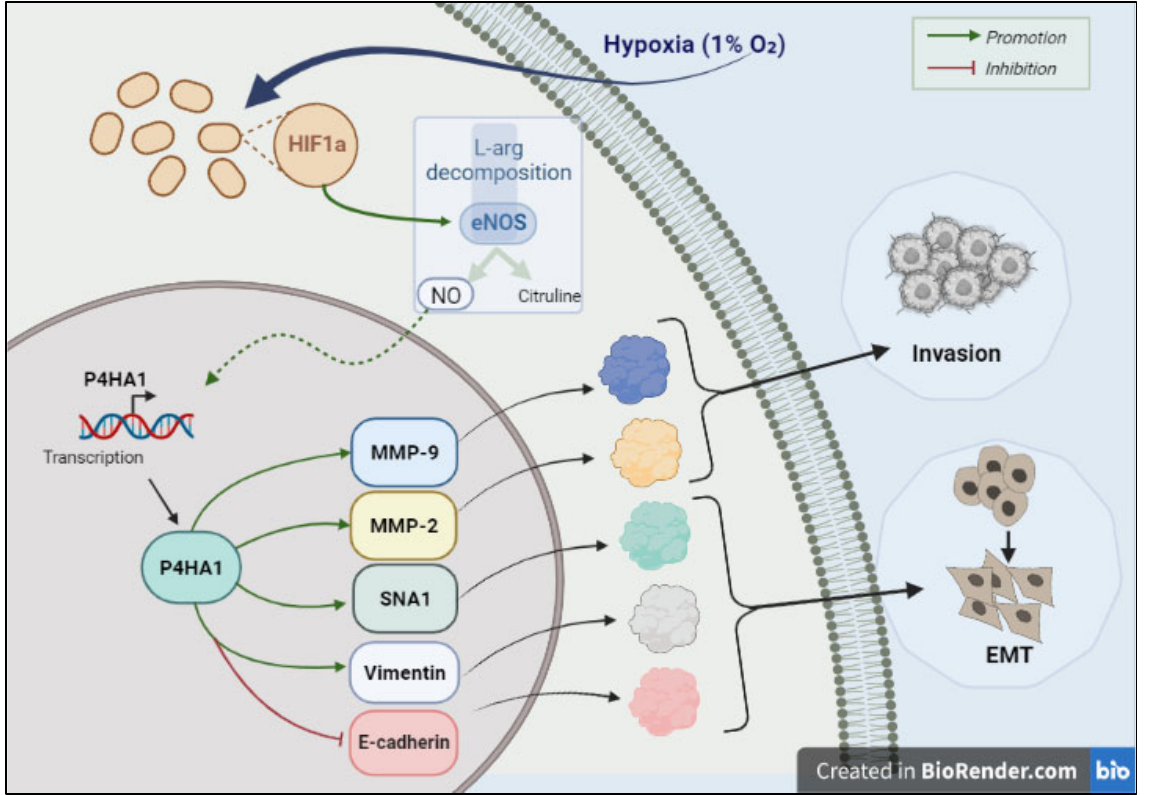
Figure 3. A diagrammatic illustration of the downstream signaling cascade associated with glioblas ‐ toma cell invasion induced by hypoxia. Created with BioRender.com. toma cell invasion induced by hypoxia. Created with